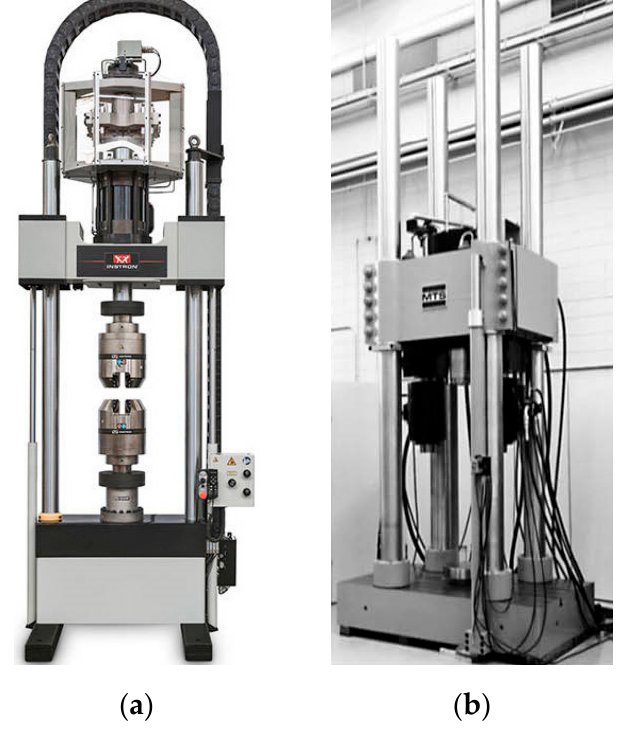
Figure 20. Fatigue test machine: ( a ) Instron 8803; ( b ) MTS 311.41.